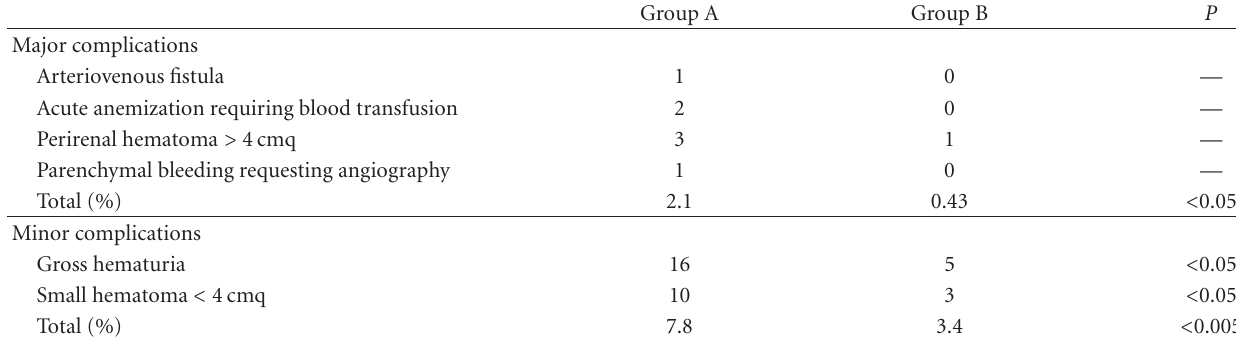
Table 2: Major and minor postbiopsy complications.